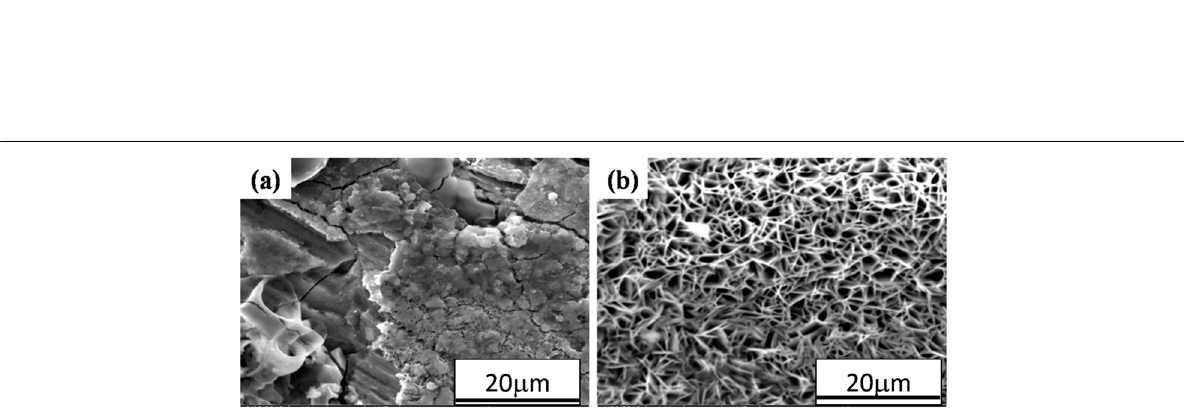
Fig. 13 Corrosion deposit morphology of a normalized and b austempered AISI 1050 steel samples after electrochemical testing in 3.5% NaCl